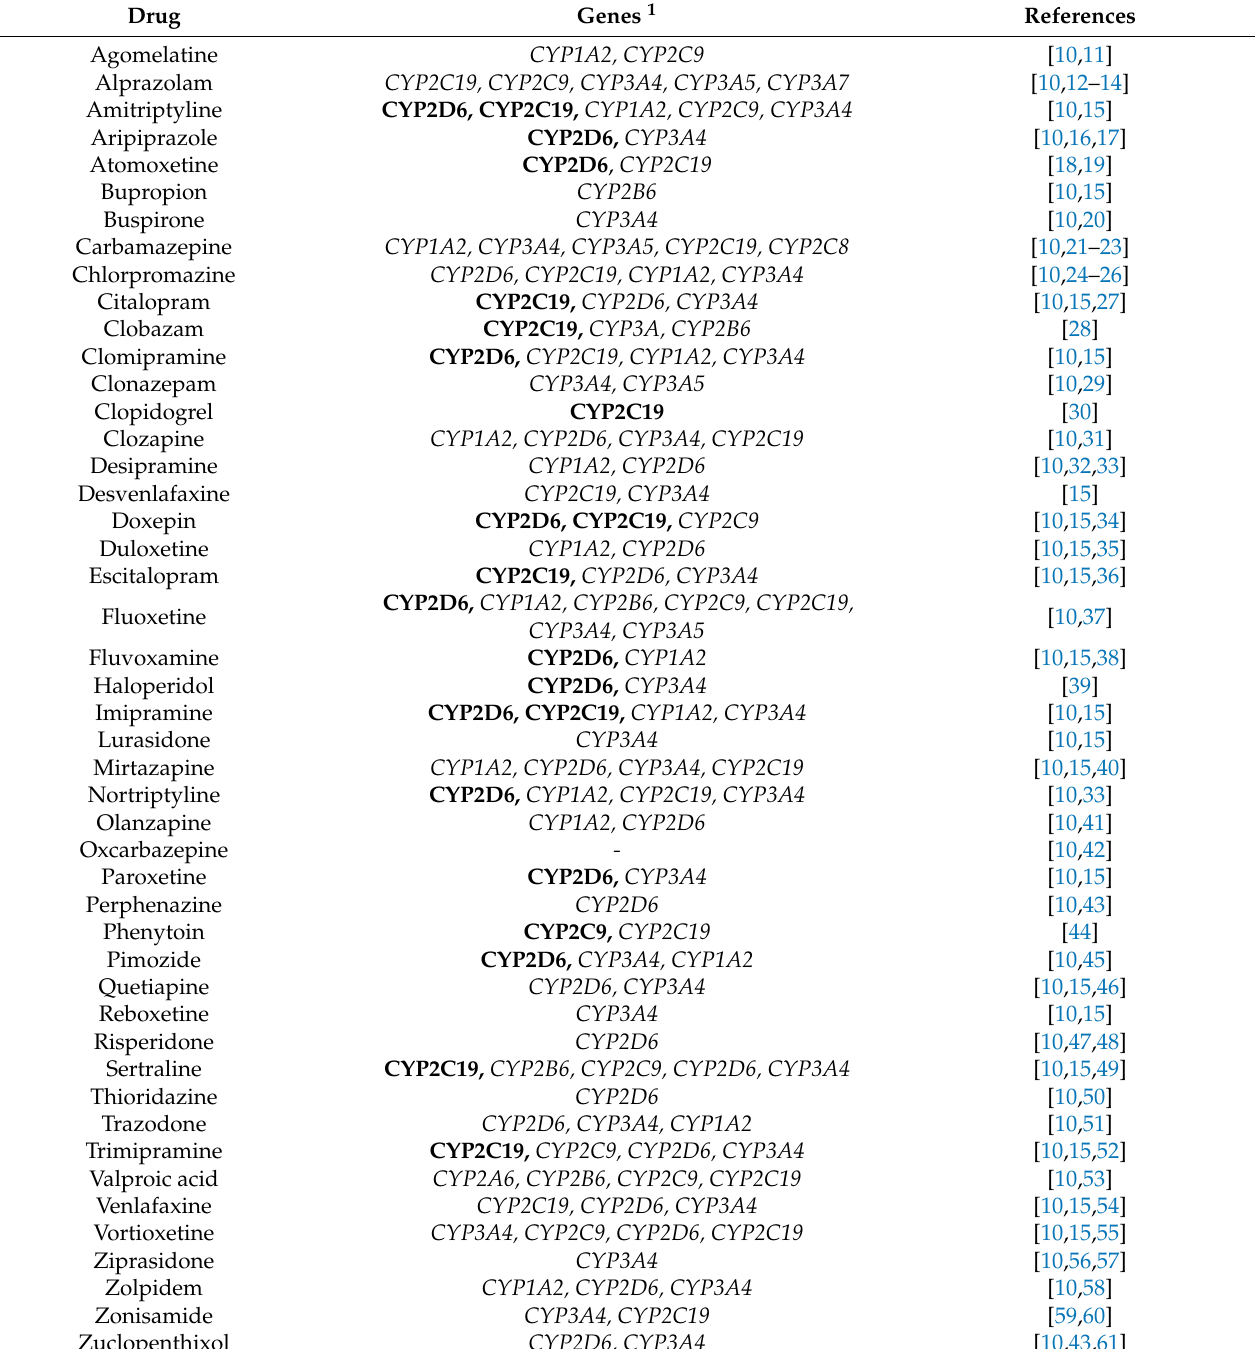
1 in bold genes which genotypes suggest a different drug administration, in italic genes associated with a different drug metabolism, but not included in guidelines [10]. From all CYP genes, CYP3A5 , CYP2B6 , CYP2C9 , CYP2C19, and CYP2D6 were selected for their large representation in guidelines. Thirty-nine SNPs were selected in order to define haplotypes associated with differential enzyme activity at CYP3A5 , CYP2B6 , CYP2C9 , CYP2C19 , and CYP2D6 . The selected SNPs and allele frequencies across populations [5] are summarized in Table